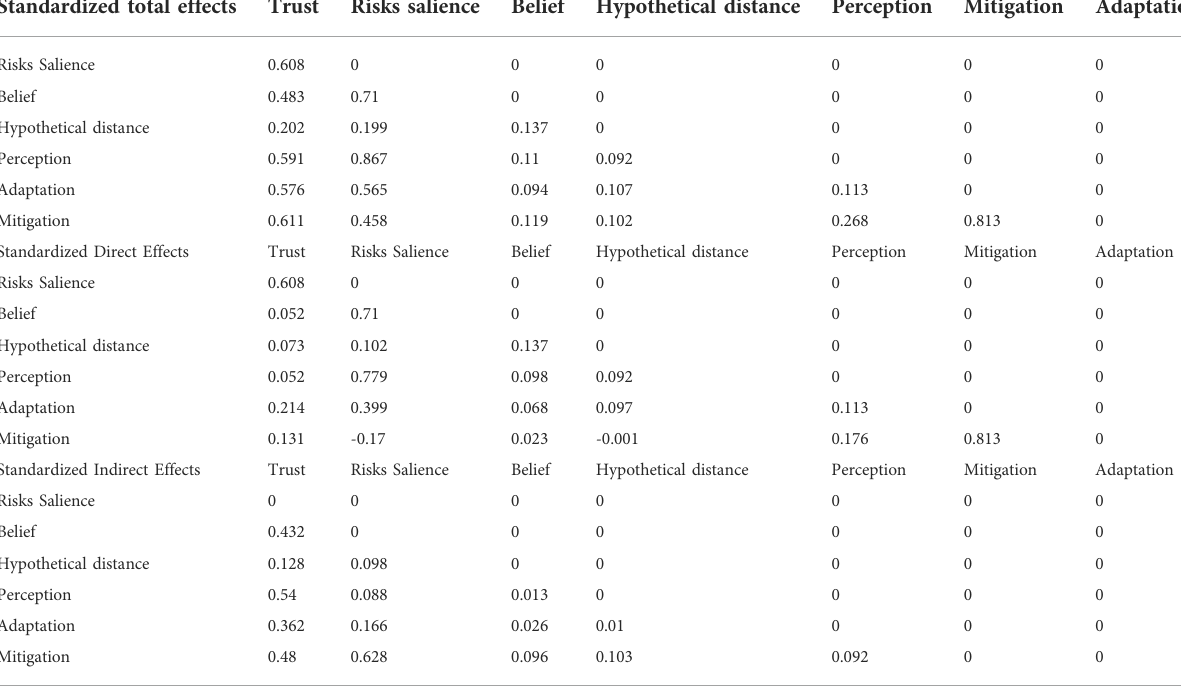
TABLE 3 The Standardized effects of the variables in